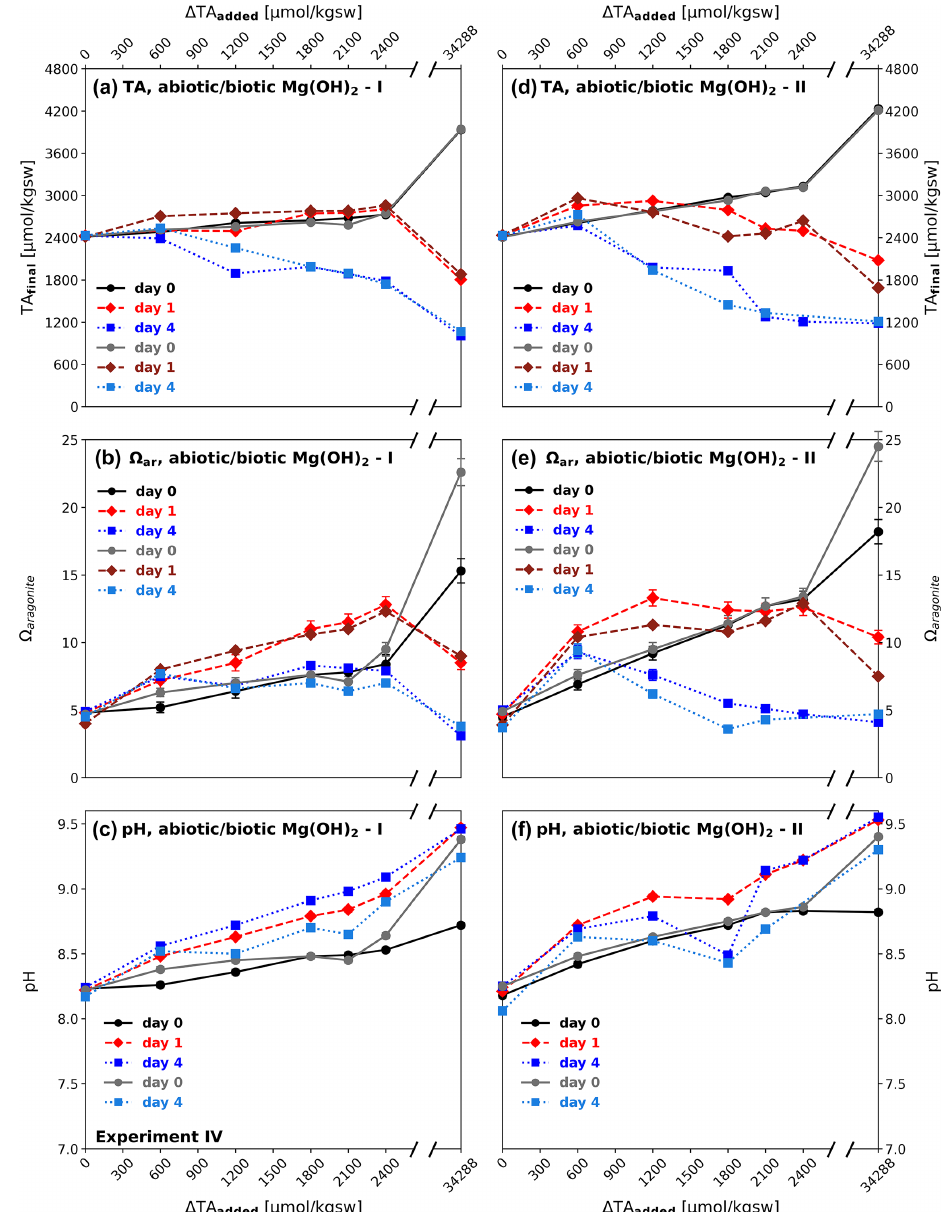
Figure 5. Dissolution of particulate brucite (types I and II) over time in experiment IV: (a, d) development of alkalinity (TA final ); (b, e) aragonite saturation state ( (cid:127) aragonite ); and (c, f) pH immediately after addition (day 0 – black/grey), 1d (red), and 4d after (blue); abiotic treatments – black, red, and dark blue graphs; biotic – grey and light blue graphs. Brucite additions range from 19.2mg ( (cid:49) TA 600 ) to 1000mg ( (cid:49) TA 34288 ). Comparable trends are observed in all treatments, independent of substrate type (brucite I and II) and set-up (abiotic/biotic).